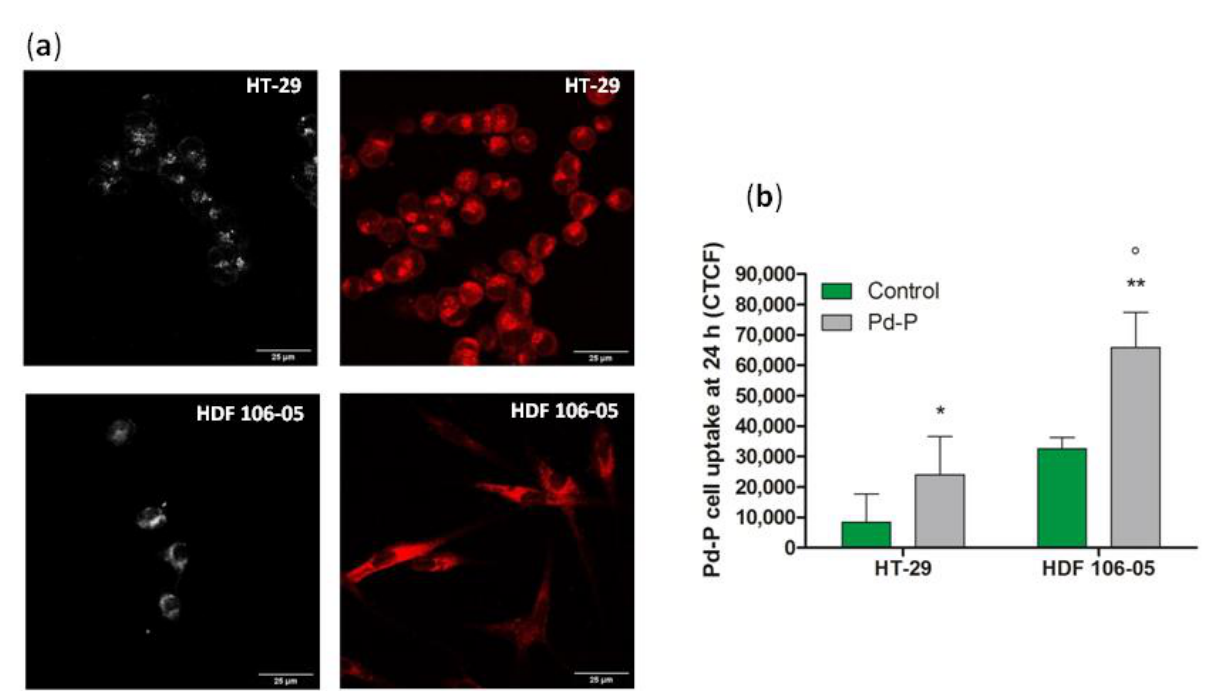
Figure 2. Pd-P cellular localization and quantification in HT-29 and HDF 105-06 cells after 24 h incubation. ( a ) Representative confocal fluorescence images of HT-29 and HDF 106-05 cells at 40 × magnification (scale bar 25 µ m): untreated HT-29 cells (bright fluorescence), HT-29 cells incubated for 24 h with 500 µ M of Pd-P (red fluorescence), untreated HFD 106-05 cells (bright fluorescence) and HFD 106-05 cells incubated for 24 h with 500 µ M of Pd-P (red fluorescence). ( b ) The confocal fluorescence quantification at 24 h is expressed as corrected total cell fluorescence (CTCF). Statistically significant difference versus untreated cells: * p < 0.05, ** p < 0.01. Statistically significant difference of HDF 106-05 cells incubated with Pd-P versus HT-29 cells incubated with Pd-P: ◦ p < 0.05.